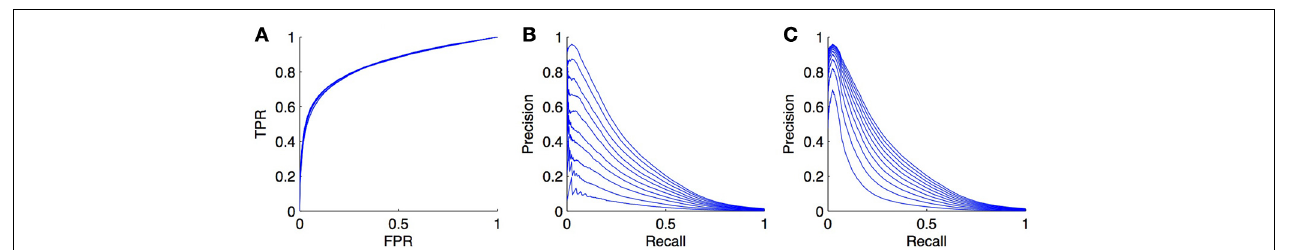
FIGURE 8 | Effect of false negatives on ROC and PR curves. We simulated false negatives in the DREAM5 regulatory network, during the testing stage. The ratio of false negatives does not influence the ROC curve (A) , but the PR curve (B) decreases while the ratio of positives turned into negatives